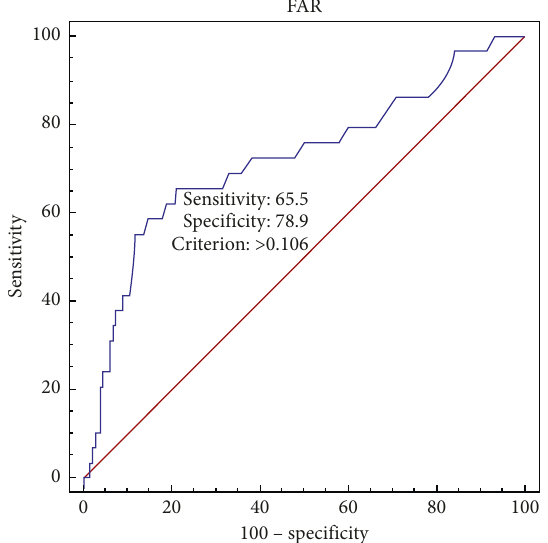
Figure 1: Receiver operator characteristic (ROC) curve analysis. ROC curve analysis demonstrated that an FAR cutoff value of 0.106 was optimal, exhibiting 65.5% sensitivity and 78.9% specificity for detecting contrast-induced nephropathy (CIN). The C-statistic was 0.721